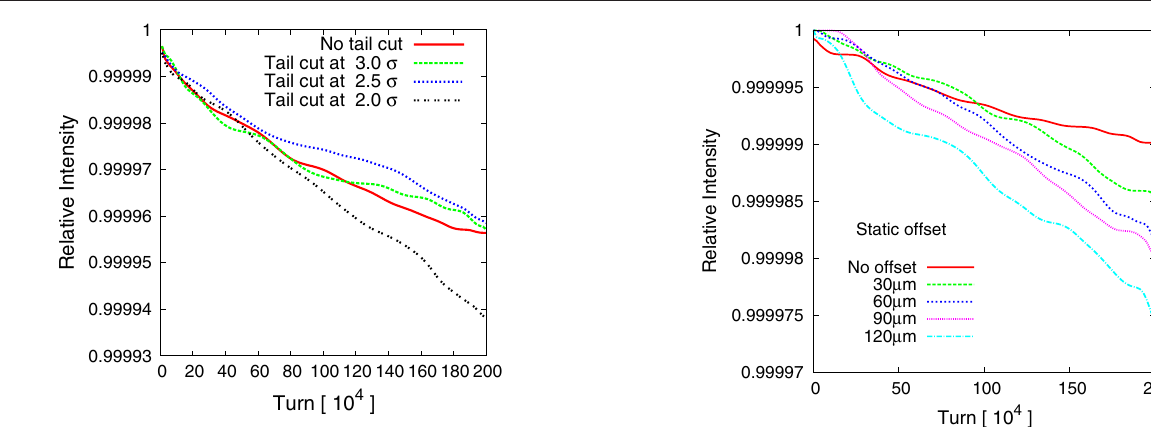
FIG. 23. Relative proton beam loss with static transverse offset between the e-lens and the proton beam in the e-lens.